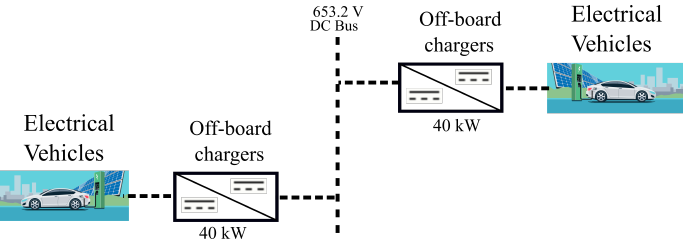
Figure 12. Illustration of V2V or vehicle to Vehicle mode, in which one vehicle charges another.